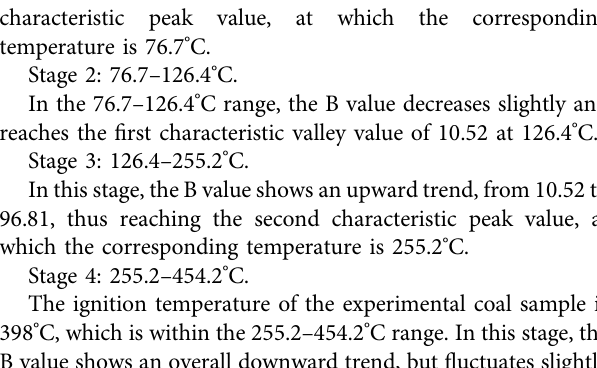
Frontiers in Materials |